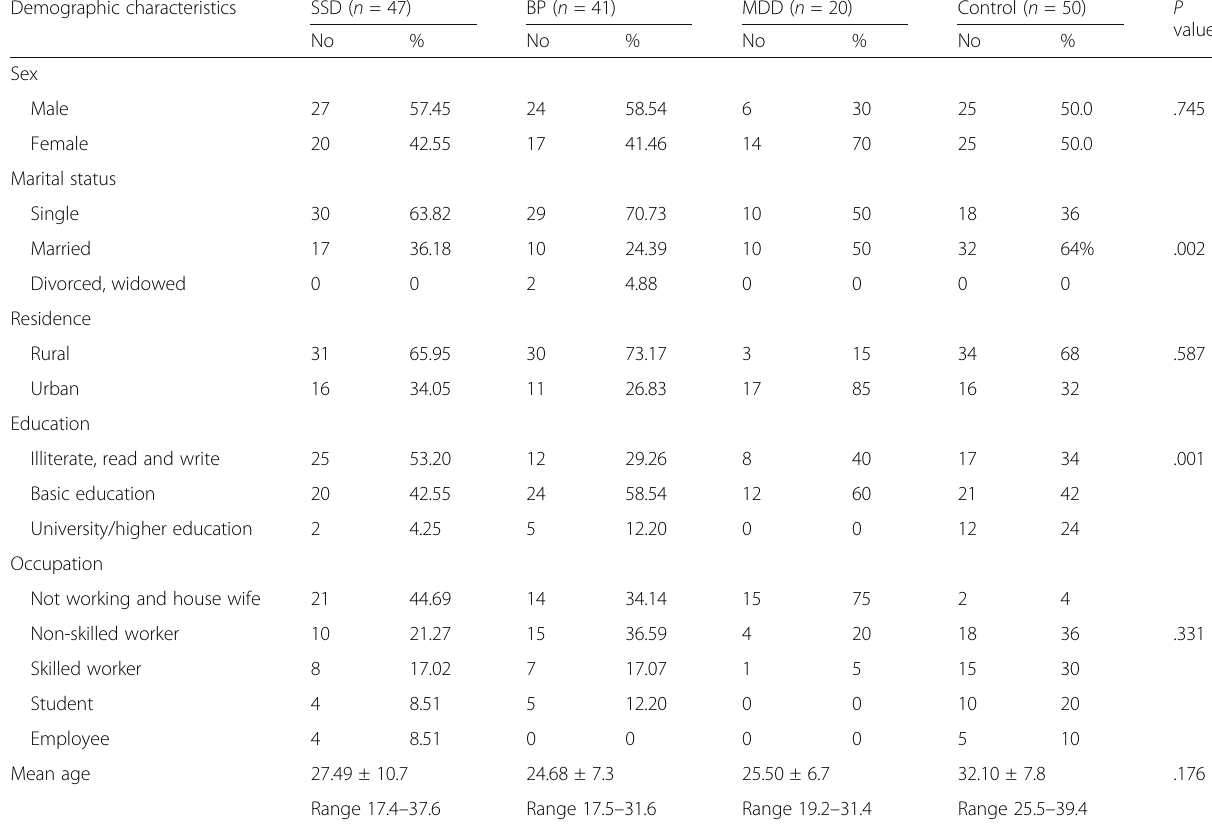
Table 2 Demographic characteristics of first-episode psychosis patients and control groups Demographic